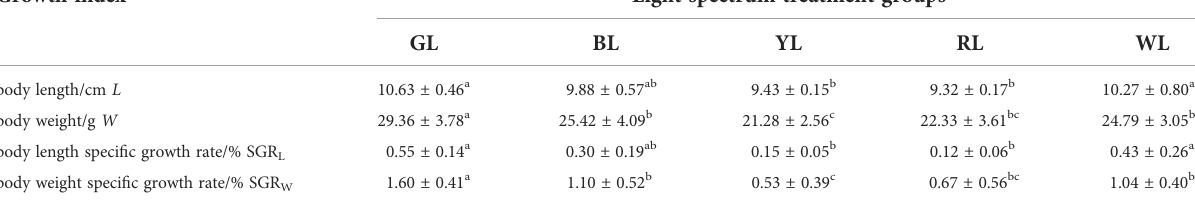
TABLE 2 Growth indexes of juvenile Takifugu rubripes under different spectral conditions (Liu et al., 2021) n =9; ±SD. Growth